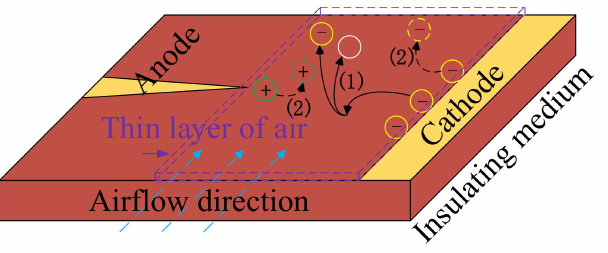
Figure 8. Analytical diagram of ion motion in an airflow environment.